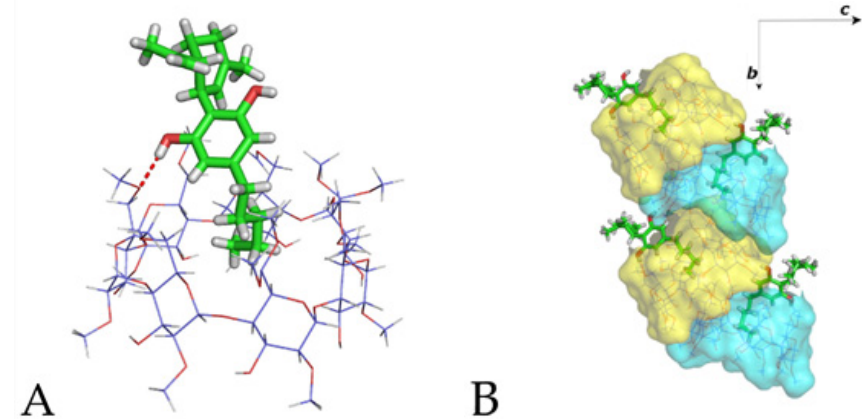
Figure 3. ( A ) The asymmetric unit of the CBD/DM- β - CD crystal structure and ( B ) the “herring bone” mode arrangement of the complex units along the b